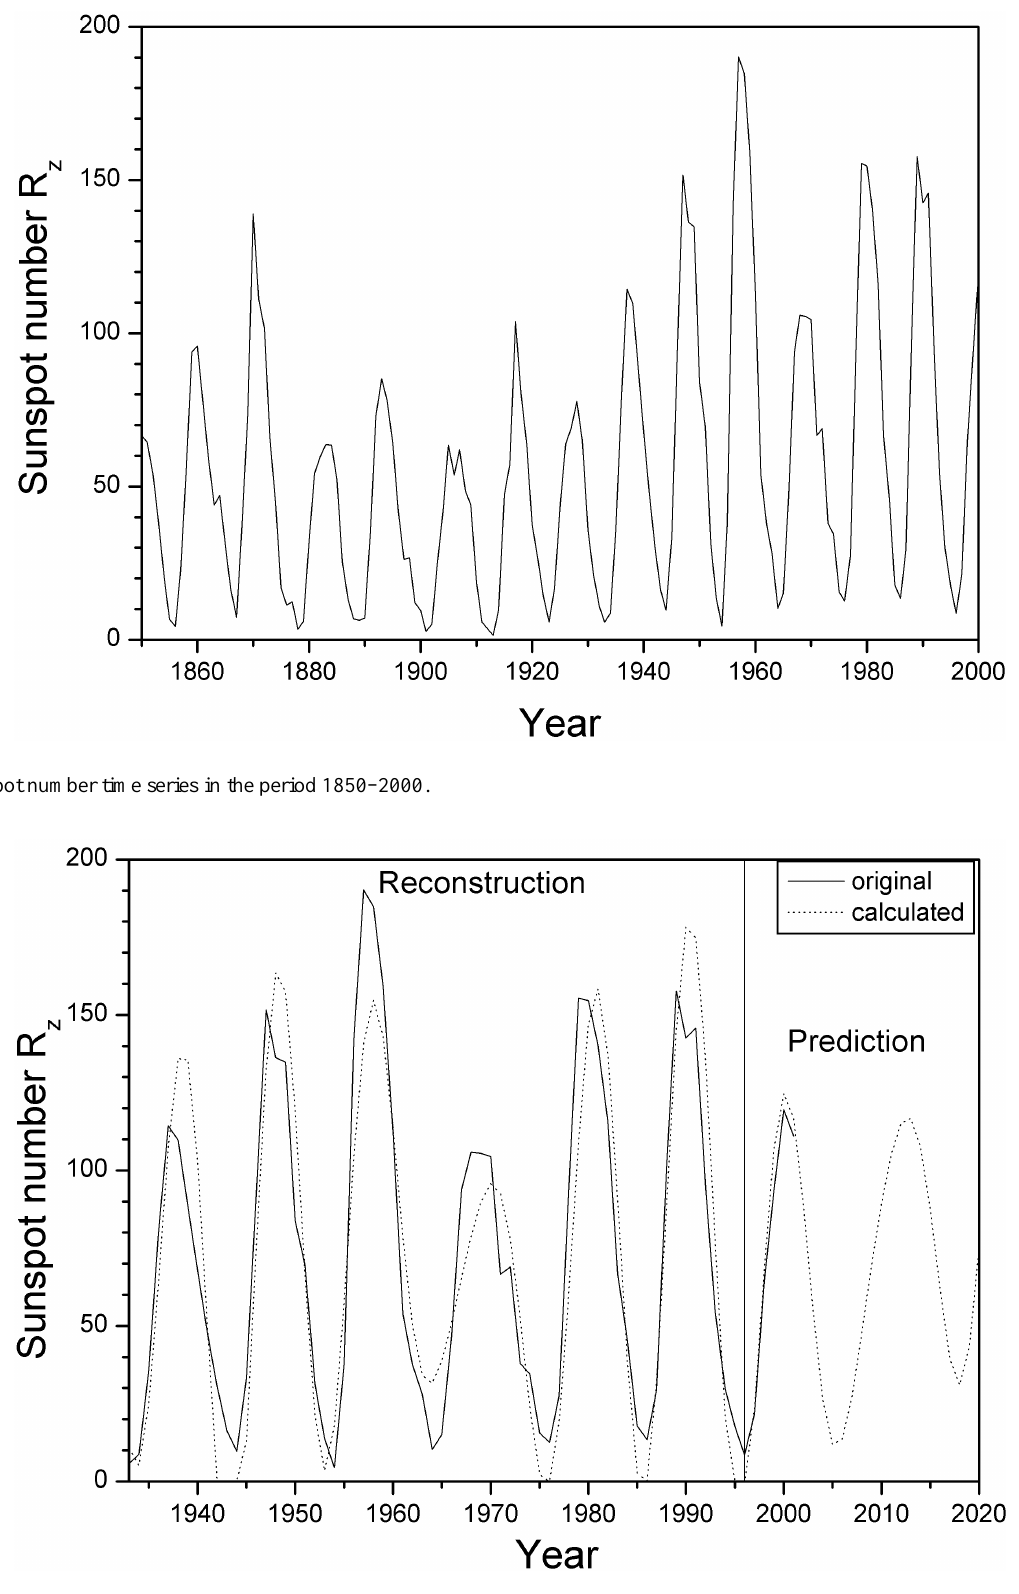
Fig. 2. Reconstructed/forecasted (dotted lines) and original (continuous line) sunspot number series. The continuous line in 1996 divides the reconstructed and predicted